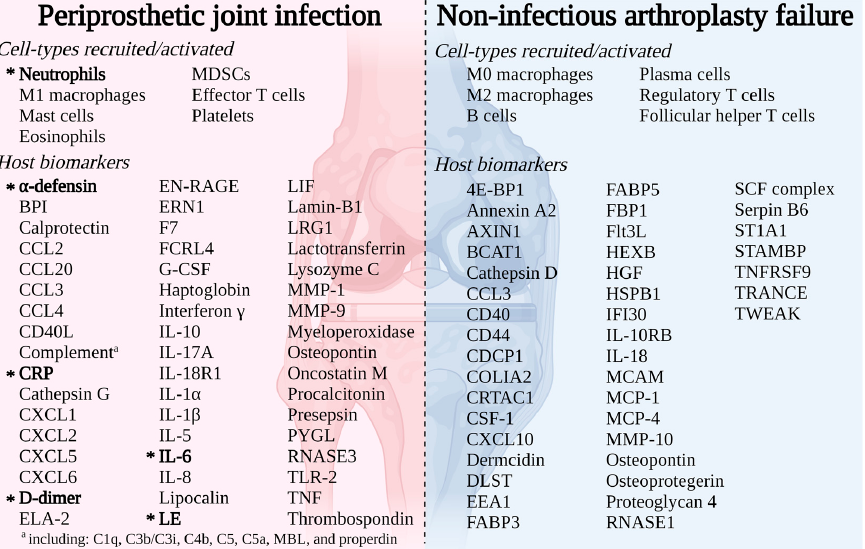
Figure 4. Immune response to arthroplasty failure due to periprosthetic joint infection (PJI) or non-infectious arthroplasty failure (NIAF) detailing cell-types recruited/activated and host markers. Bolded, starred (*) entries represent those currently used for the diagnosis of PJI. Abbreviations used: 4E-BP1, eukaryotic translation initiation factor 4E (eIF4E)-binding protein 1; BCAT1,